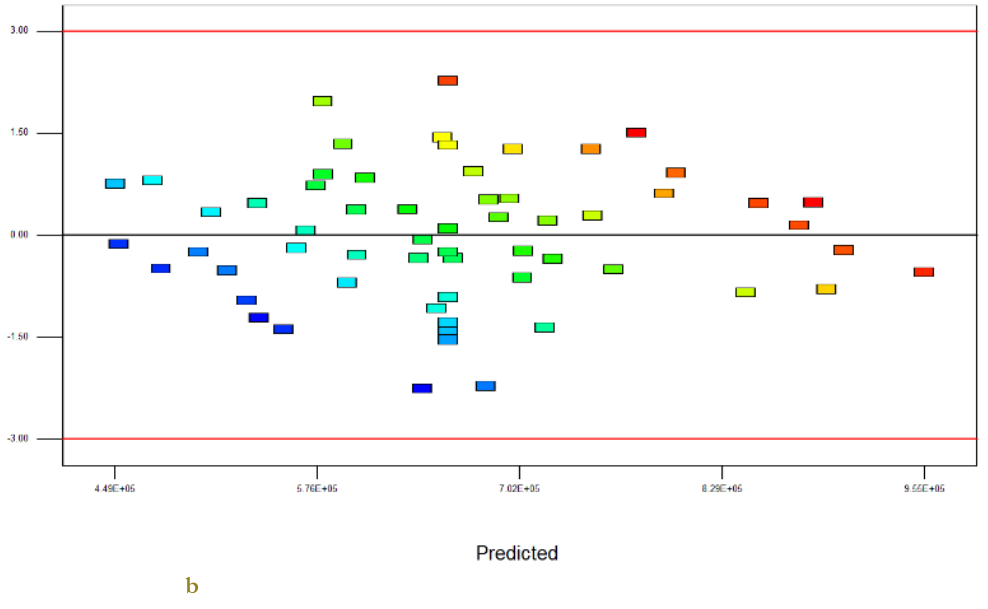
Fig. 6. The related graph for RSM: a. normal plot of residuals, b. residuals vs. predicted.